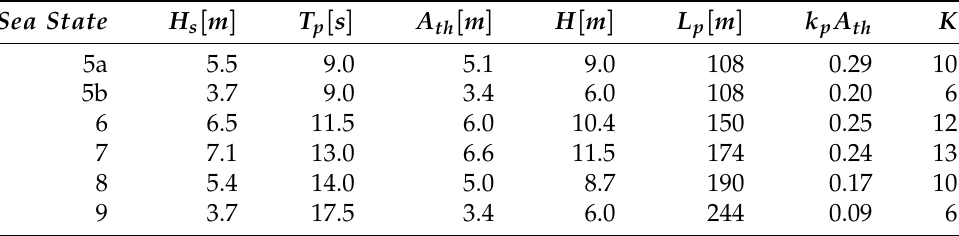
Table 1. Characteristics of the sea states 5 to 9, along the Dowsing environmental contour. H s and T p are the significant wave height and peak period, respectively. The maximum theoretical crest amplitude of the focused wave, A th , is calculated following the New Wave theory. The wave height of the focus wave, H , is defined as the height between the maximum wave crest and the minimum wave trough. L p is the peak wave length, the parameter k p A th measures the steepness of the waves, where k p corresponds to the peak frequency, and KC is the Keulegan–Carpenter number